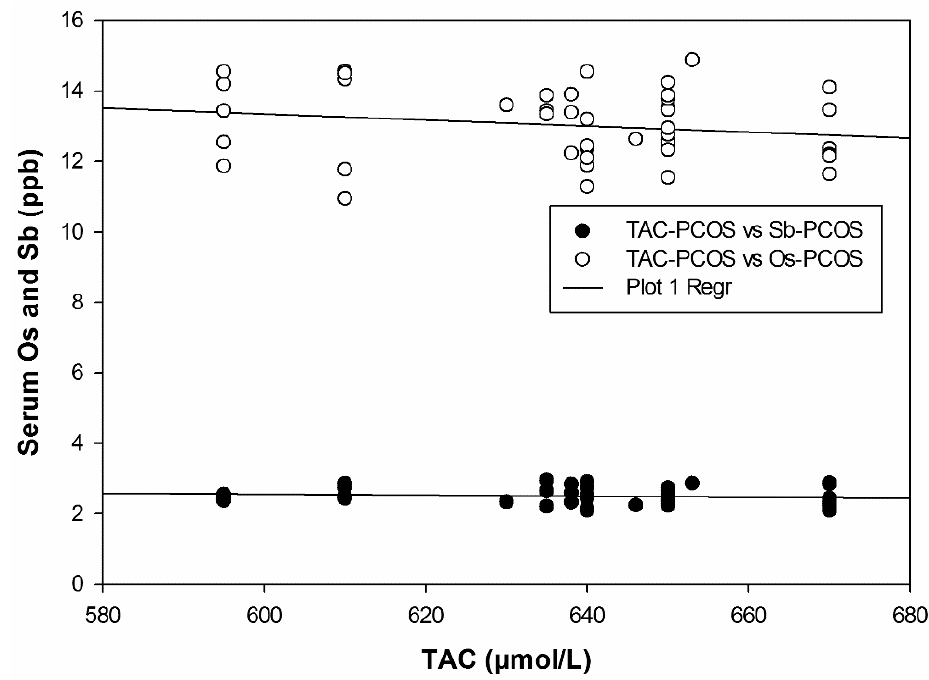
Figure 2. Multiple regression plot of Os and Sb with TAC in PCOS.